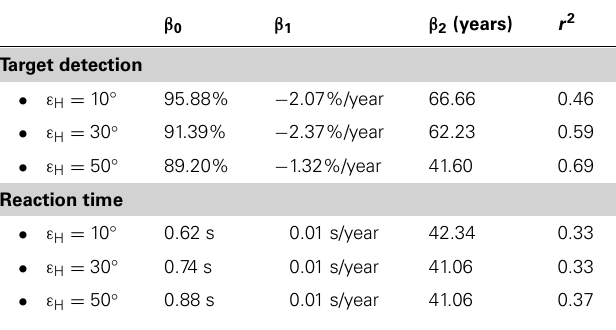
Table 1 |Values of the linear broken-line regression analysis for the target detection performance and the reaction time.